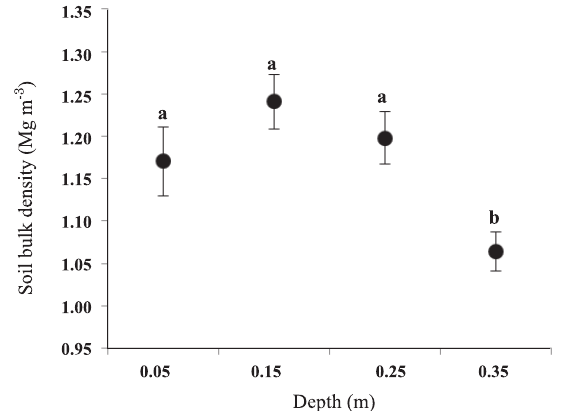
figure 2. mean values of soil density and respective confidence intervals before chiseling. same letters indicate overlap of the confidence intervals at the different